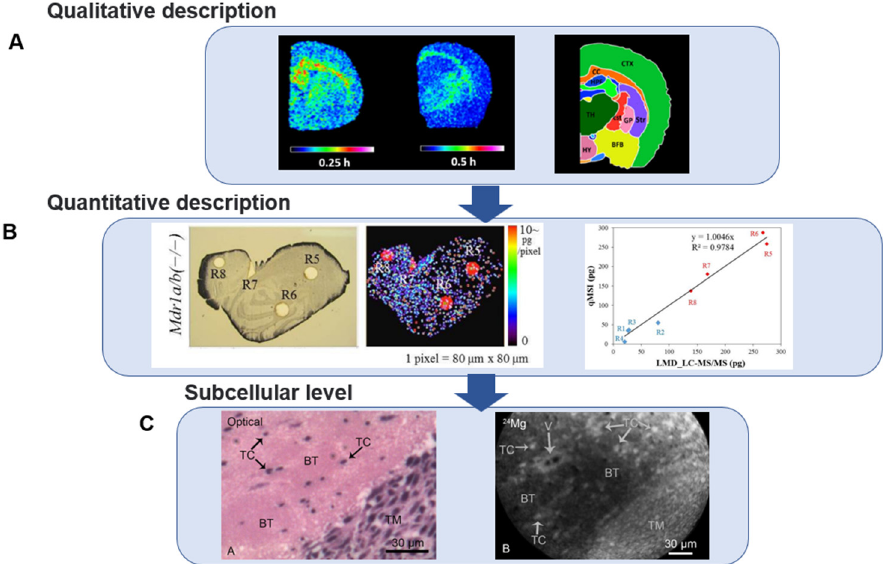
Figure 3. Development process of mass spectrometry imaging technology. ( A ) Qualitative description: Ion images combined with anatomical mapping showed that RPV was able to reach almost all brain regions after administration. A high degree of m / z 367.0 localization was observed in hippocampal structures (HPF) and corpus callosum (CC) at 0.25 h. Reprinted with permission from Ref. [74]. © 2019, Sphamandla Ntshangase. ( B ) Quantitative description: calibration curves of alectinib standards and images of alectinib distribution in sections of mouse brain. In the calibration curve on the right, R1-R4 (blue) and R5-R8 (red) present FVB (section not shown) and Mdr1a/b KO (section shown on the left) of mouse with different genes, respectively. Reprinted with permission from Ref. [75]. © 2016, HiroakiAikawa. ( C ) Subcellular level: H&E images and SIMS images of magnesium distribution in the brains of F98 glioma rats. H&E image shows the interface between the tumor mass (TM) in brain tissue (BT)of infiltrating tumor cells (TC). SIMS image shows higher magnesium concentrations in TM and TC. Reprinted with permission from Ref. [81]. © 2015, Subhash Chandra.